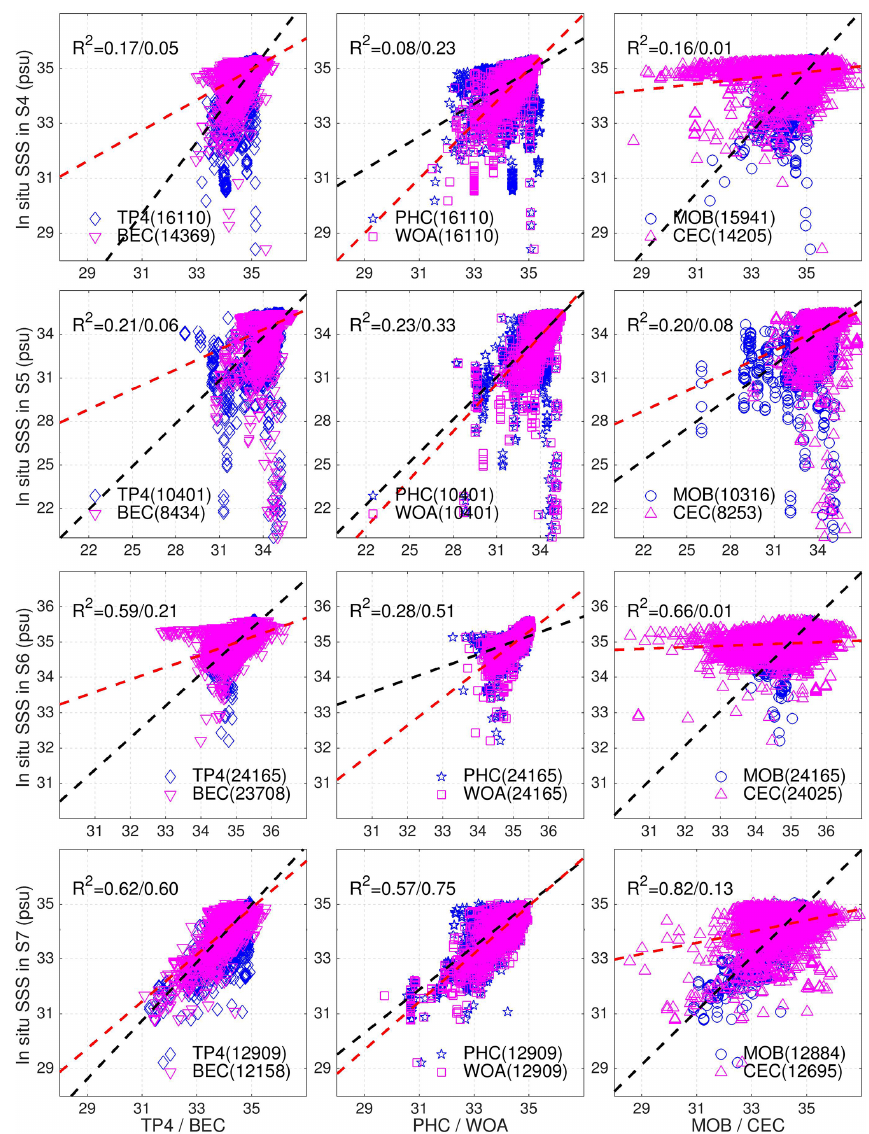
Figure 8. Same as Fig. 7 but for the subpolar regions